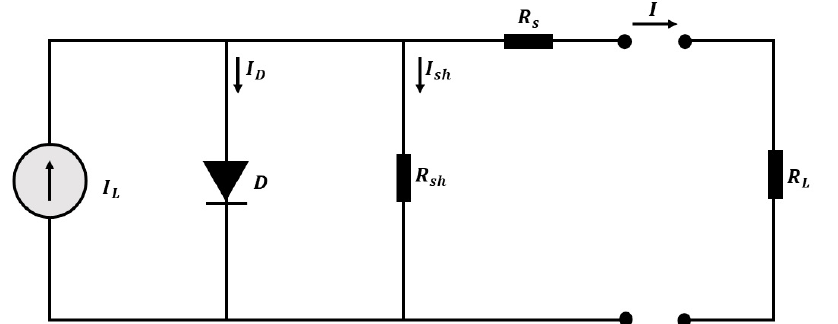
Figure 2. Electrical model for a PV panel